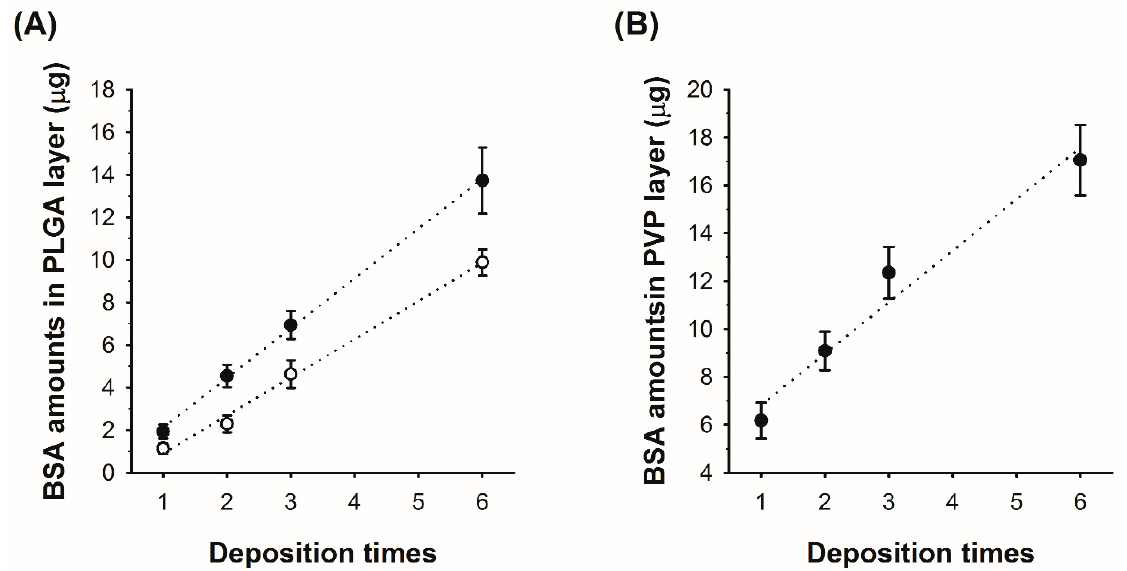
Figure 3. Total amount of bovine serum albumin (BSA) loaded in each layer of the microneedles according to the number of spray depositions. ( A ) The amount of BSA in the PLGA layer. Open and filled circles represent 1:20 and 1:15 volume ratios of aqueous BSA to organic PLGA solutions, respectively. ( B ) The amount of BSA amounts in the PVP layer.